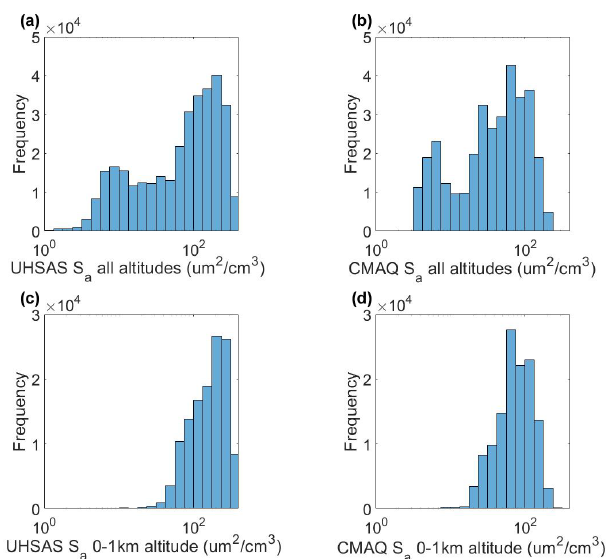
Figure 5. Histograms of (a) measured aerosol surface area con- centration (DISCOVER-AQ) at all altitudes, (b) modeled aerosol surface area concentration (CMAQ) at all altitudes, (c) measured aerosol surface area in the 0 to 1km altitude bin, and (d) modeled aerosol surface area in the 0 to 1km altitude bin over the entirety of the DISCOVER-AQ campaign.